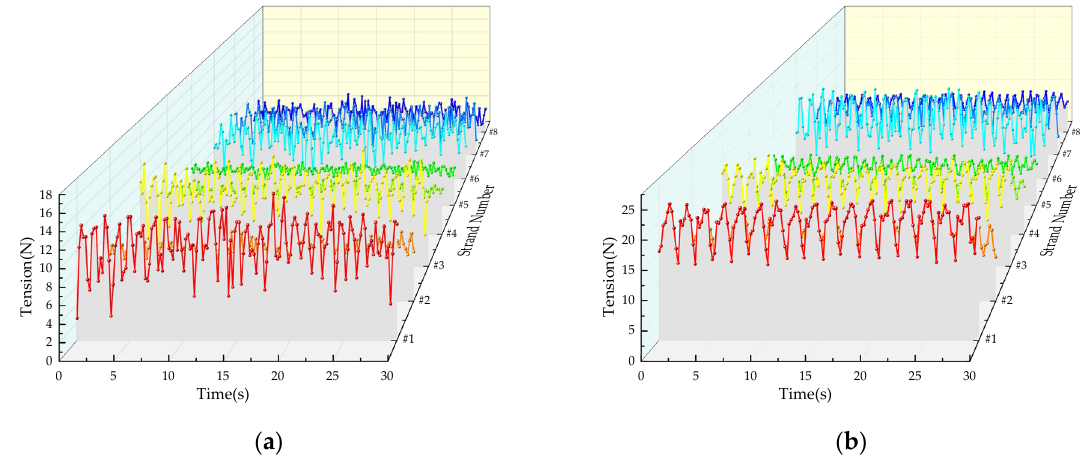
Figure 8. ( a ) 20 0 r/min tension data of each strand; and ( b ) 30 0 r/min tension data of each strand. Figure 8. ( a ) 200 r/min tension data of each strand; and ( b ) 300 r/min tension data of each The range of tension fluctuation of each strand at 20 0 r/min and 300 r/min is pre- sented in box plots in Figure 9. As the speed increase d , the range of the tension fluctuation and the average tension of each strand increased. For the same speed, when the strand had a significant deviation at the distribution reel, the average tension increased, indicat- ing an increase in the overall force on the strand. When the deviation of the strand at the distribution reel was small, the range of the tension fluctuation obviously decreased. It is evident that the change of the strand twisting-deviation path affects the range of the ten- sion fluctuation.